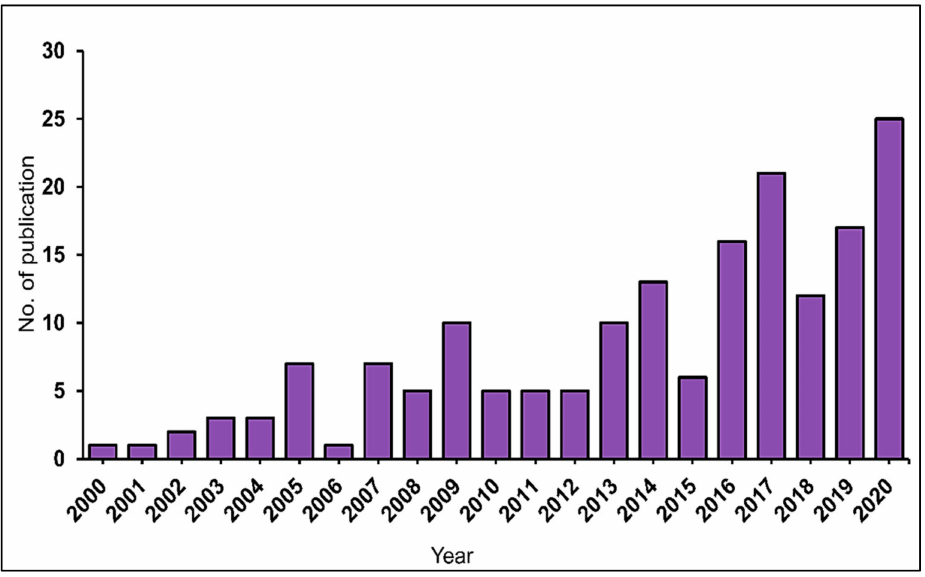
Figure 2. Distribution of publication from